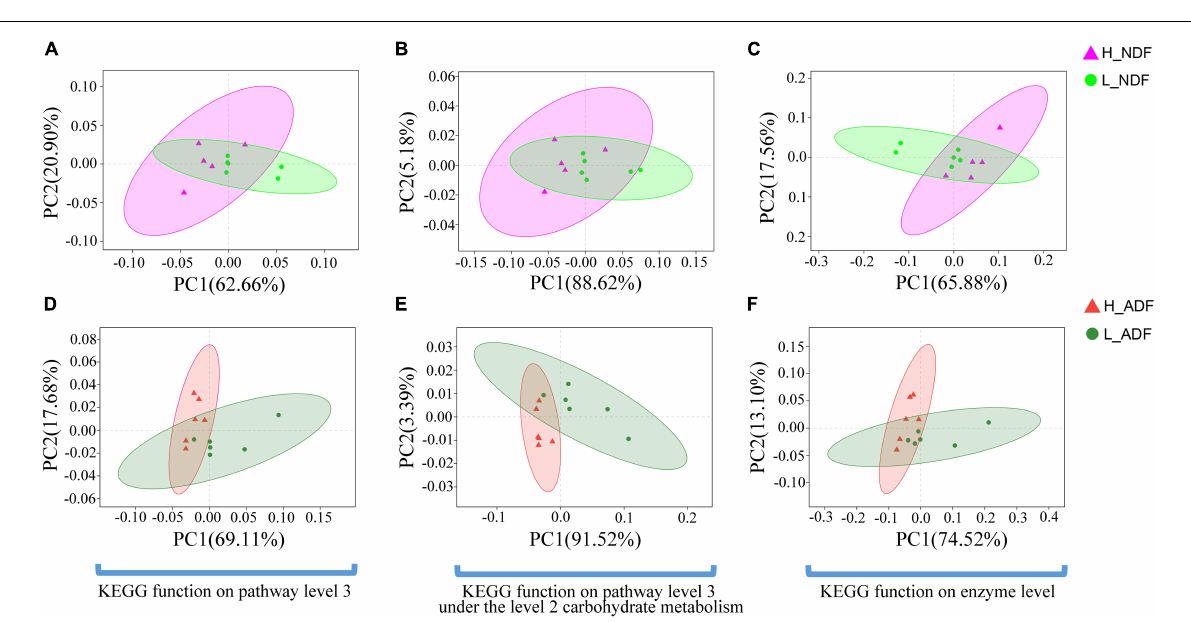
FIGURE 9 | The principal coordinates analysis (PCoA) shows the significant difference in KEGG function diversity between H_NDF and L_NDF groups and between H_ADF and L_ADF groups. (A) ( PERMANOVA , P = 0.048) shows the significant difference in the KEGG function on pathway level 3 of H_NDF and L_NDF groups. (B) ( PERMANOVA , P = 0.053) shows the difference in the KEGG function on pathway level 3 under the level 2 carbohydrate metabolism of H_NDF and L_NDF groups. (C) ( PERMANOVA , P = 0.033) shows the significant difference in the KEGG function on enzyme level of H_NDF and L_NDF groups. (D) ( PERMANOVA , P = 0.006) shows the significant difference in the KEGG function on pathway level 3 of H_ADF and L_ADF groups. (E) ( PERMANOVA , P = 0.006) shows the significant difference in the KEGG function on pathway level 3 under the level 2 carbohydrate metabolism of H_ADF and L_ADF groups. (F) ( PERMANOVA , P = 0.021) shows the significant difference in the KEGG function on enzyme level of H_ADF and L_ADF